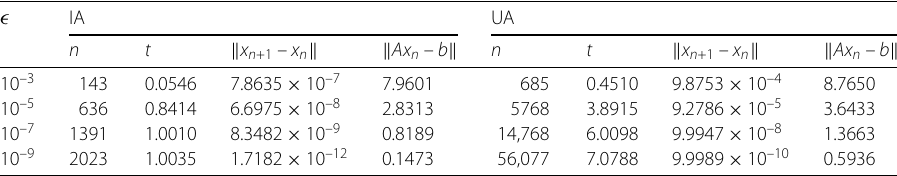
Table 1 Comparison of Algorithm 1 (IA) with the algorithm without inertia step (UA) for Example 4.1. x 0 = randn( N ,1) (cid:15)